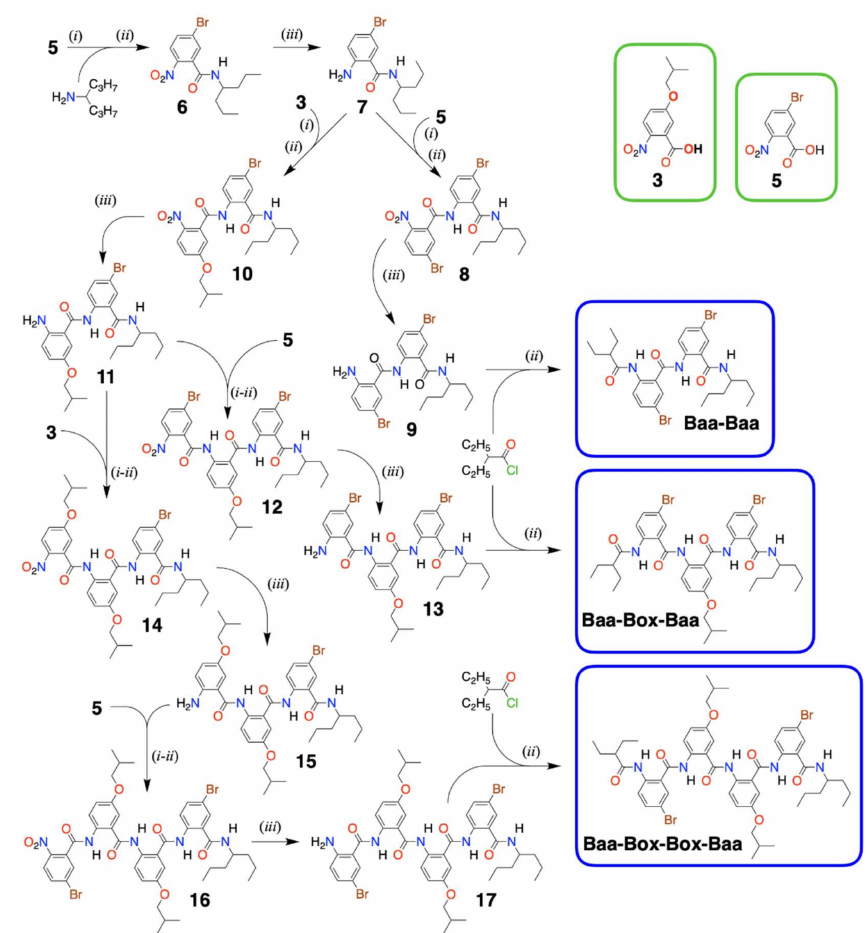
Figure 4. Synthesis of different bioinspired molecular electrets (in the blue frames) from two NBA precursors for Aa residues (i.e., 3 for Box and 5 for Baa (in the green frames)) employing ( i ) carboxylate activation, ( ii ) amid coupling, and ( iii ) nitro reduction; ( i , ii ) designates in situ activation (i.e., the carboxylate activation is carried out in the presence of the N-terminal amine). To attach NBA derivatives to a Baa N-terminal amine, chlorination activation ( i ) of the NBA carboxylates was carried out separately, prior to amid coupling ( ii ) (i.e., (1) NBA, (COCl) 2 , DCM, DMF, − 78 ◦ C to r.t., 1 h; (2) N-terminal amine, DCM, pyridine, − 78 ◦ C to r.t., overnight, 59% yield for 7 → 8 and 33% for 7 → 10 ). To attach NBA derivatives to a Box N-terminal amine, carbodiimide carboxylate